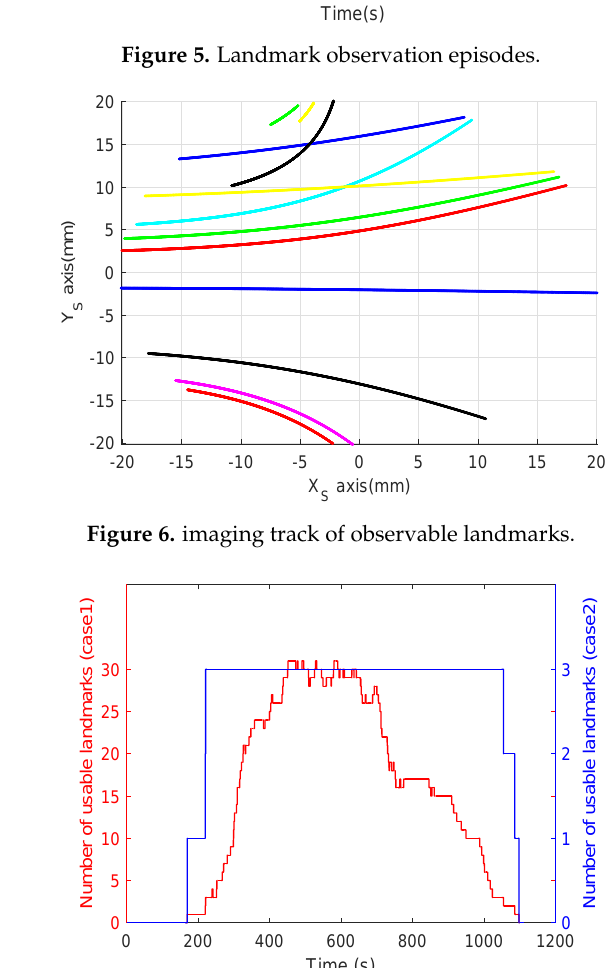
Figure 7. number of the visible